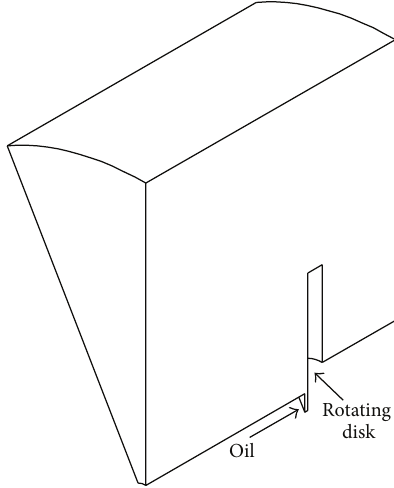
Figure 7: Computational domain of oil film on a rotating